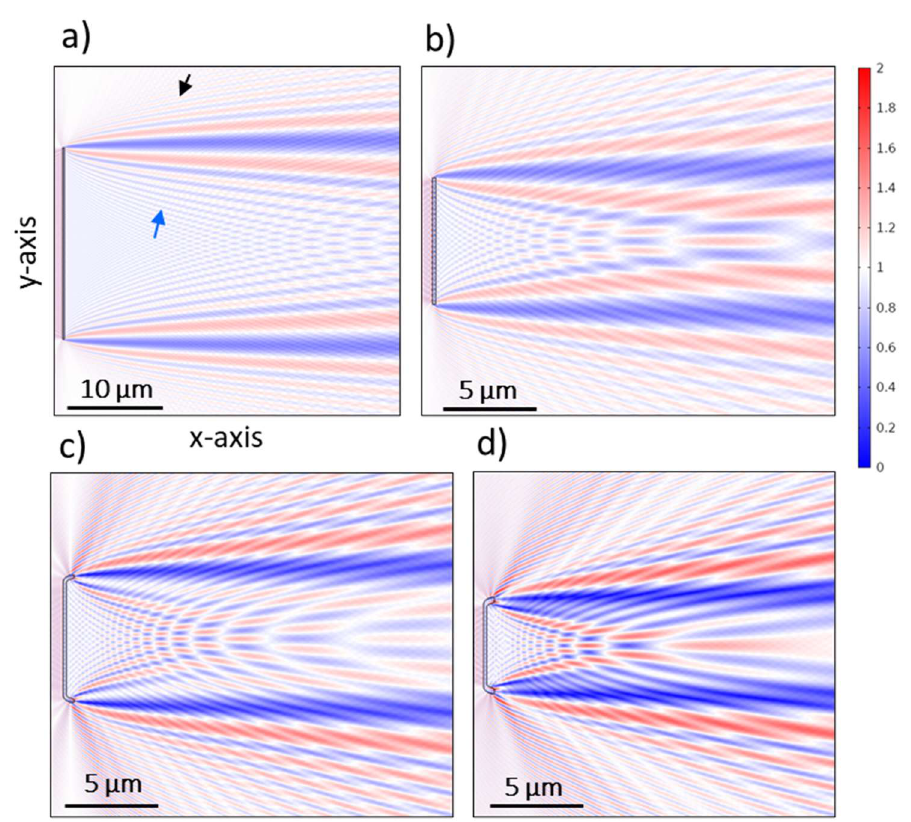
Figure 5. A thin slab of 20 µm length ( a ), S ana,long5 ( b ), CS long,5 ( c ), and CS long,7 ( d ) at λ vacc = 300 nm in the air. The black and blue arrows in ( a ) indicate the fringes outside and inside the transmittance region, respectively.